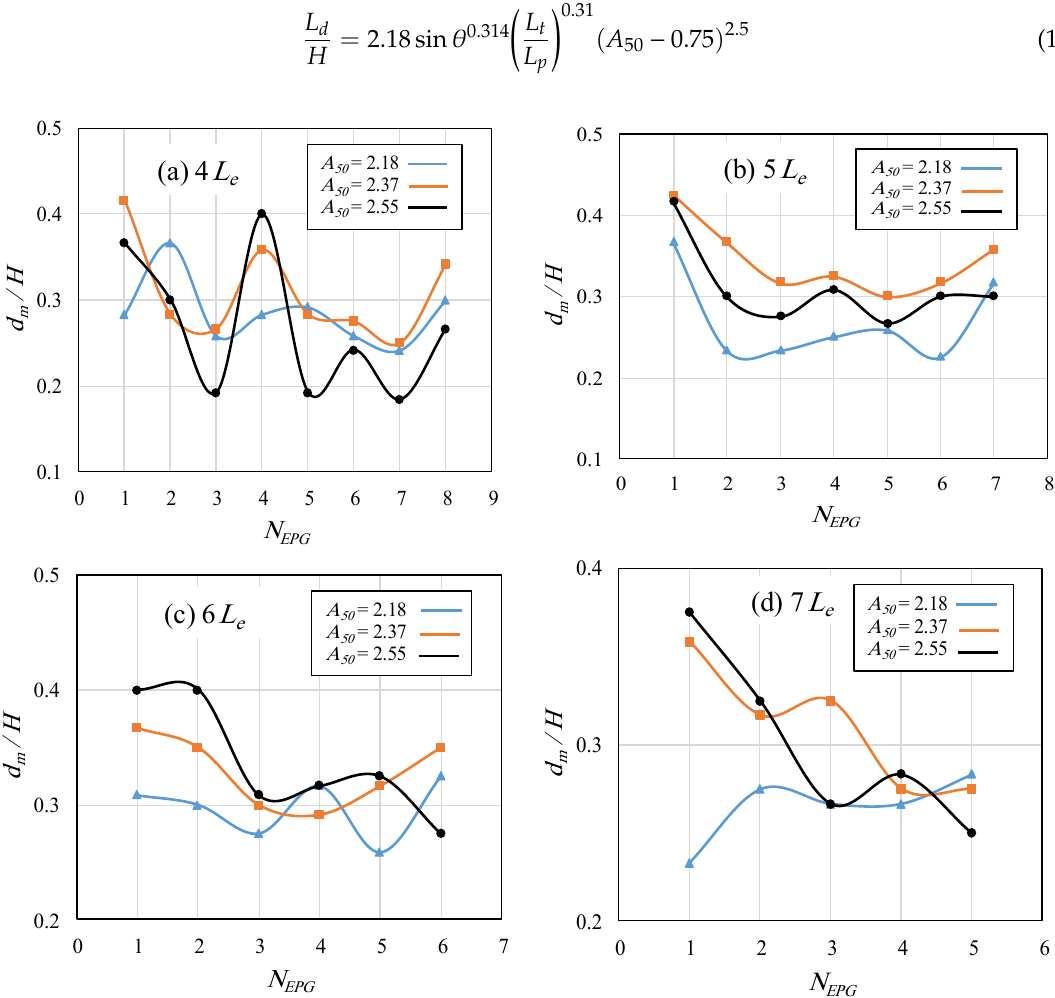
Figure 14. Relationship between the maximum scour length occurred around the first EPG and the maximum scour length in the other EPGs at di ff erent distances and hydraulic conditions. ( a ) 4 L e , ( b ) 5 L e , ( c ) 6 L e , and ( d ) 7 L e .